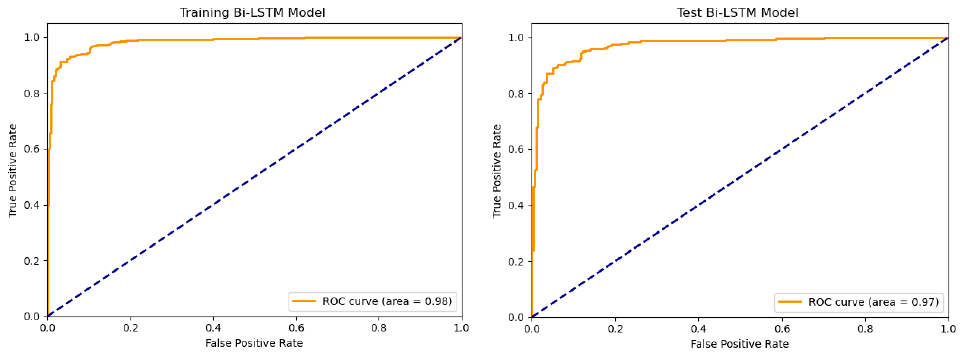
Figure 7. Bi-LSTM model ROC curve.